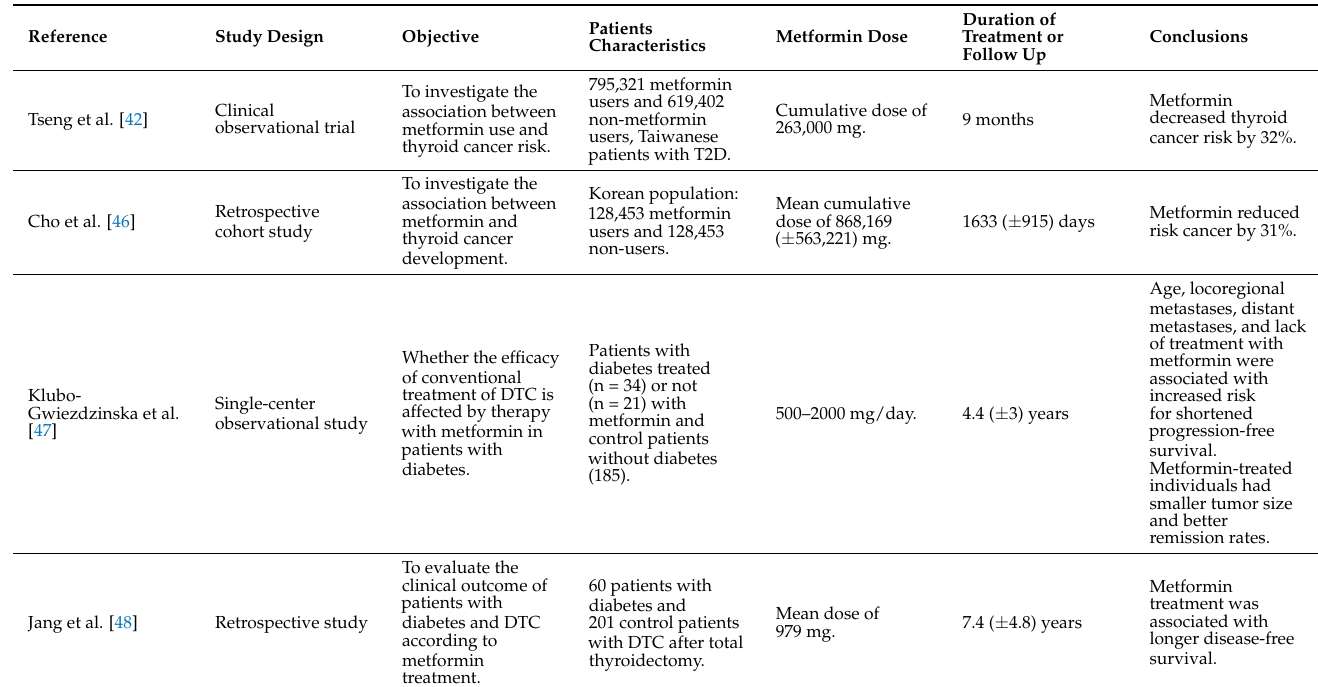
Table 2. Effects of metformin on thyroid cancer as reported in clinical